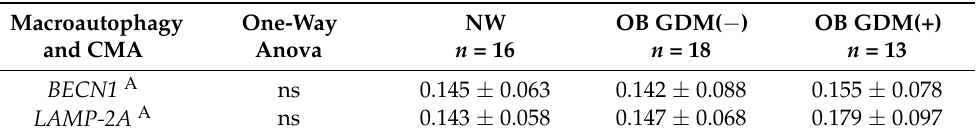
Figure 2. CAT placental levels ( A ) according to placental efficiency (PEff) cut-off and ( B ) in relation to PEff. ( A ) Data are shown as box plots, indicating the median and the 25th and 75th percentiles. * p < 0.05 ( t -test); ( B ) statistical analysis by the Spearman rank order correlation (r = +0.6, p < 0.001) in NW ( ○ ), OB GDM( − ) ( ▲ ), OB GDM(+) ( ▲ ).